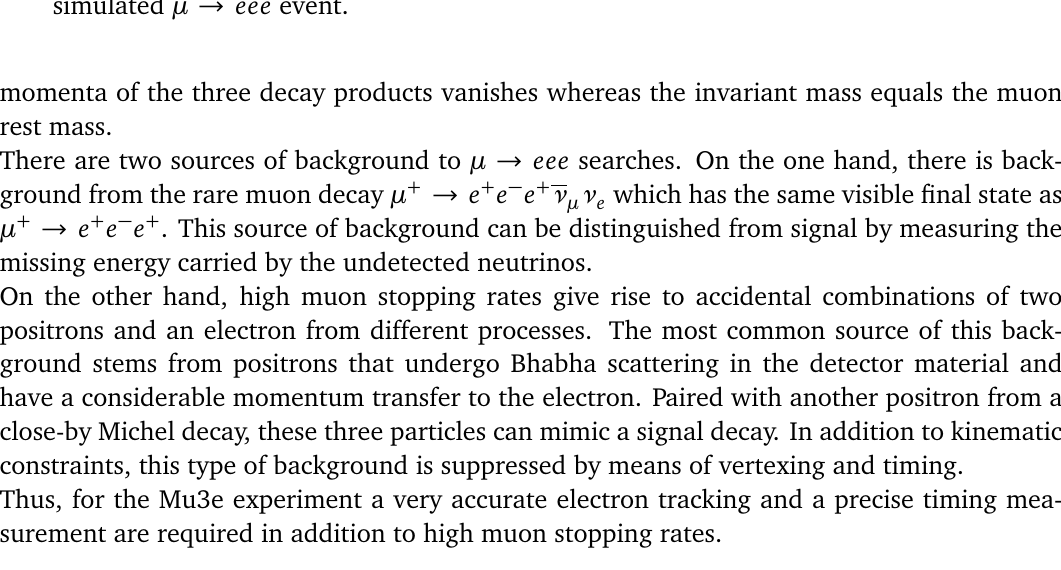
Figure 2: Schematic of the phase I Mu3e experiment in lateral projection with a simulated µ → eee